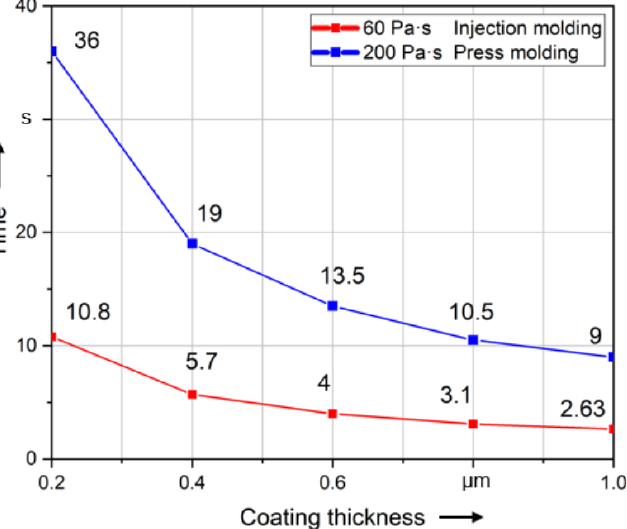
Figure 11. Time required to align long fibers (5000 µm) of different coating thicknesses to 99% of 90°.